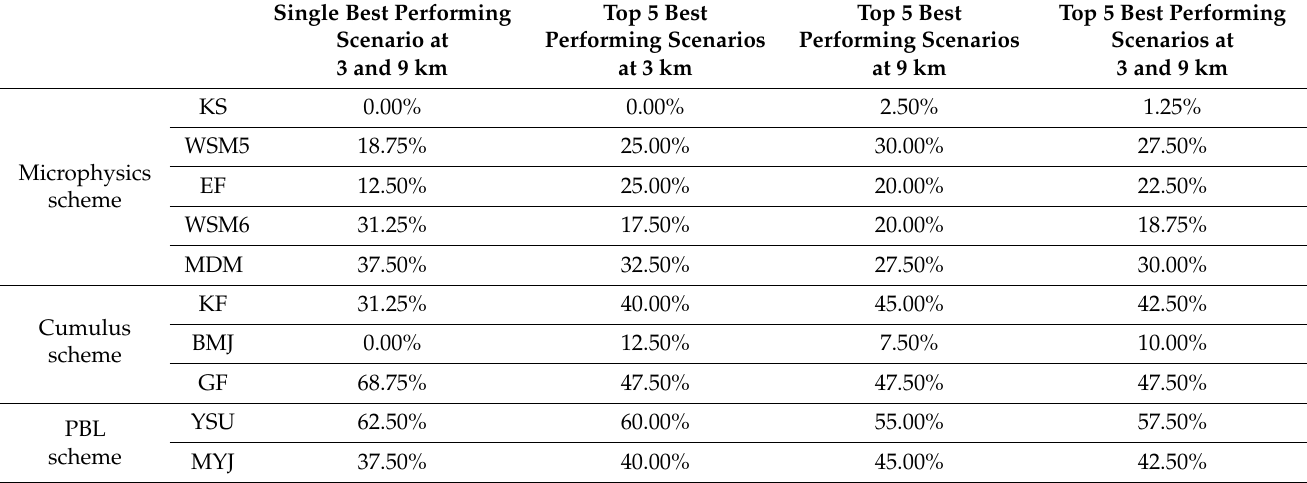
Table 5. Schemes of the best performing scenarios for the individual